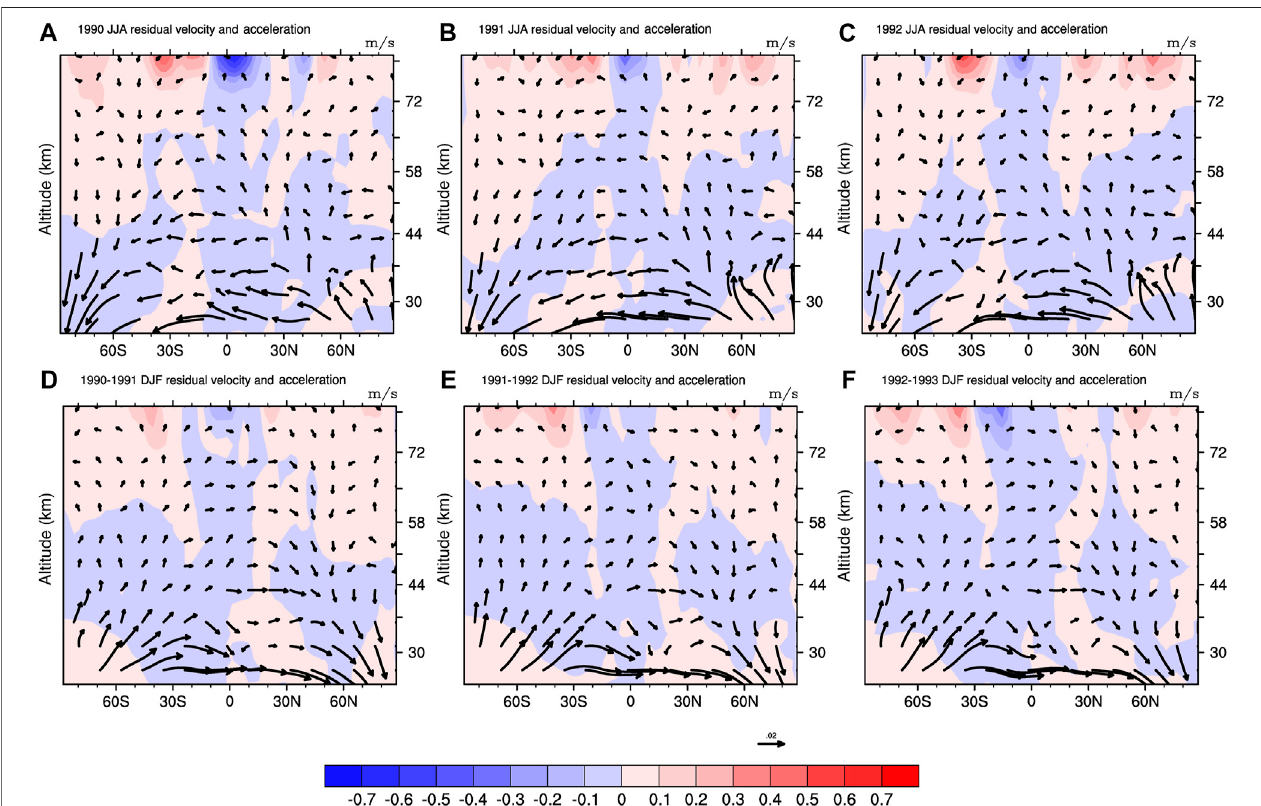
FIGURE2| Theresidualspeedandaccelerationinthesummer( fi rstrow)andwinter(secondrow)from1990to1993.Thecoloreddiagramisacceleration,andthe vector arrow is the composite of vertical wind and meridional wind ( v × 4 . 899 × 10 − 3 ).